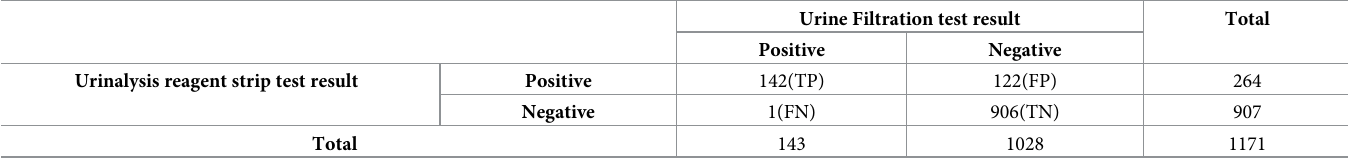
Table 4. Diagnostic performance of urinalysis reagent strip compared with urine filtration for the diagnosis of S . haematobium in school children, Abobo, Hassoba and Kurmuk village, Ethiopia,